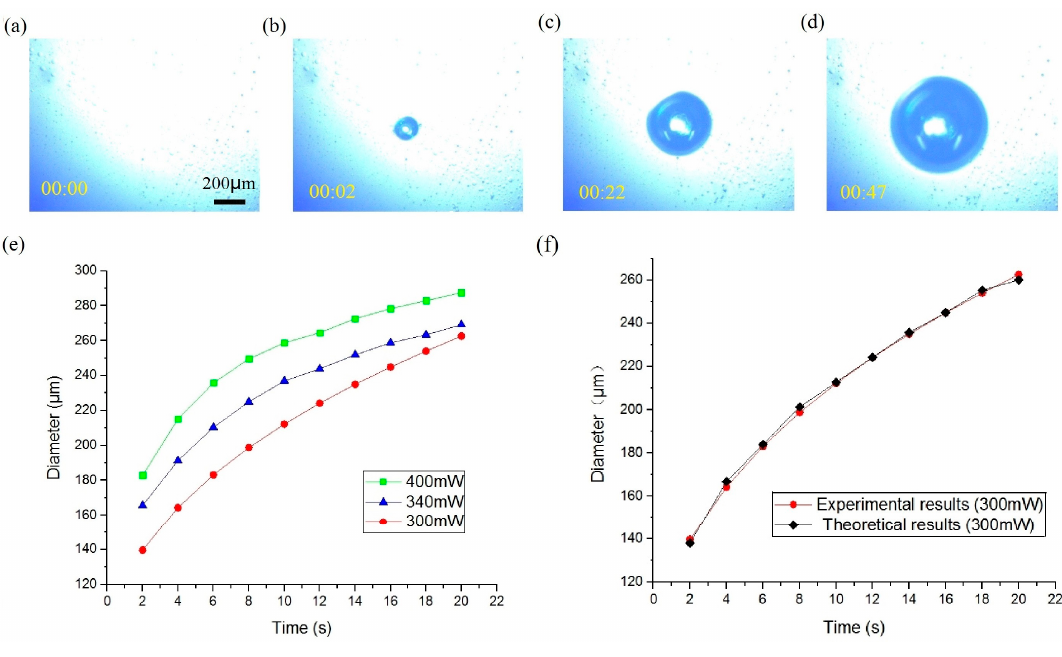
Figure 5. ( a – d ) Generation and expansion of bubble, the time stamp format is minute:second; ( e ) growth process of bubble under different conditions where the power of the laser differs; ( f ) comparison between experimental data and theoretical analysis results, where power is 300 mW.